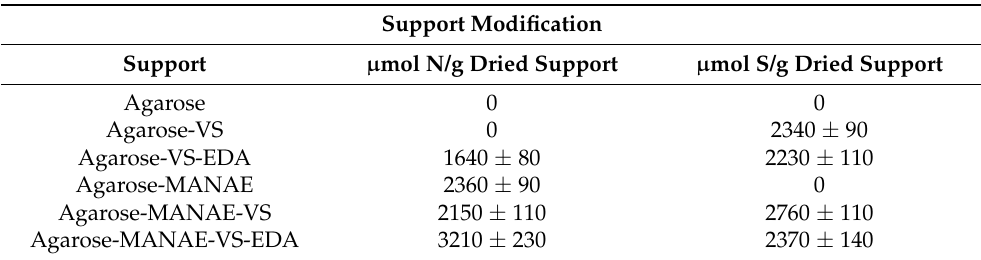
Table 1. Amounts of nitrogen and sulfur present in the different supports based on agarose beads 4% BCL after their functionalization with ethylenediamine (EDA) or divinyl sulfone. Data were obtained via elemental analysis, as described in the Methods